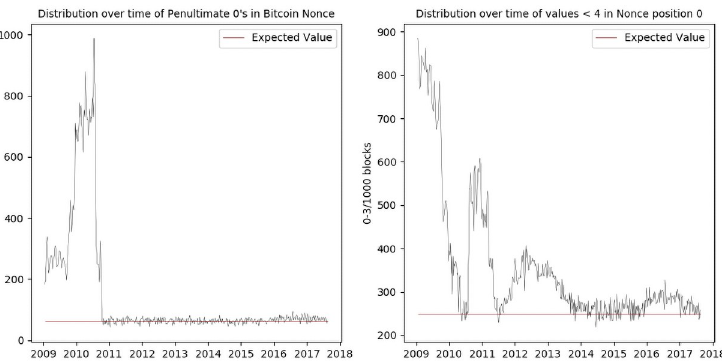
Fig 1. Anomalous patterns discovered by frequency analysis of the hexadecimal values by position in the bitcoin blockchain. A: Penultimate Zero Anomaly B: Extended Patoshi Anomaly.